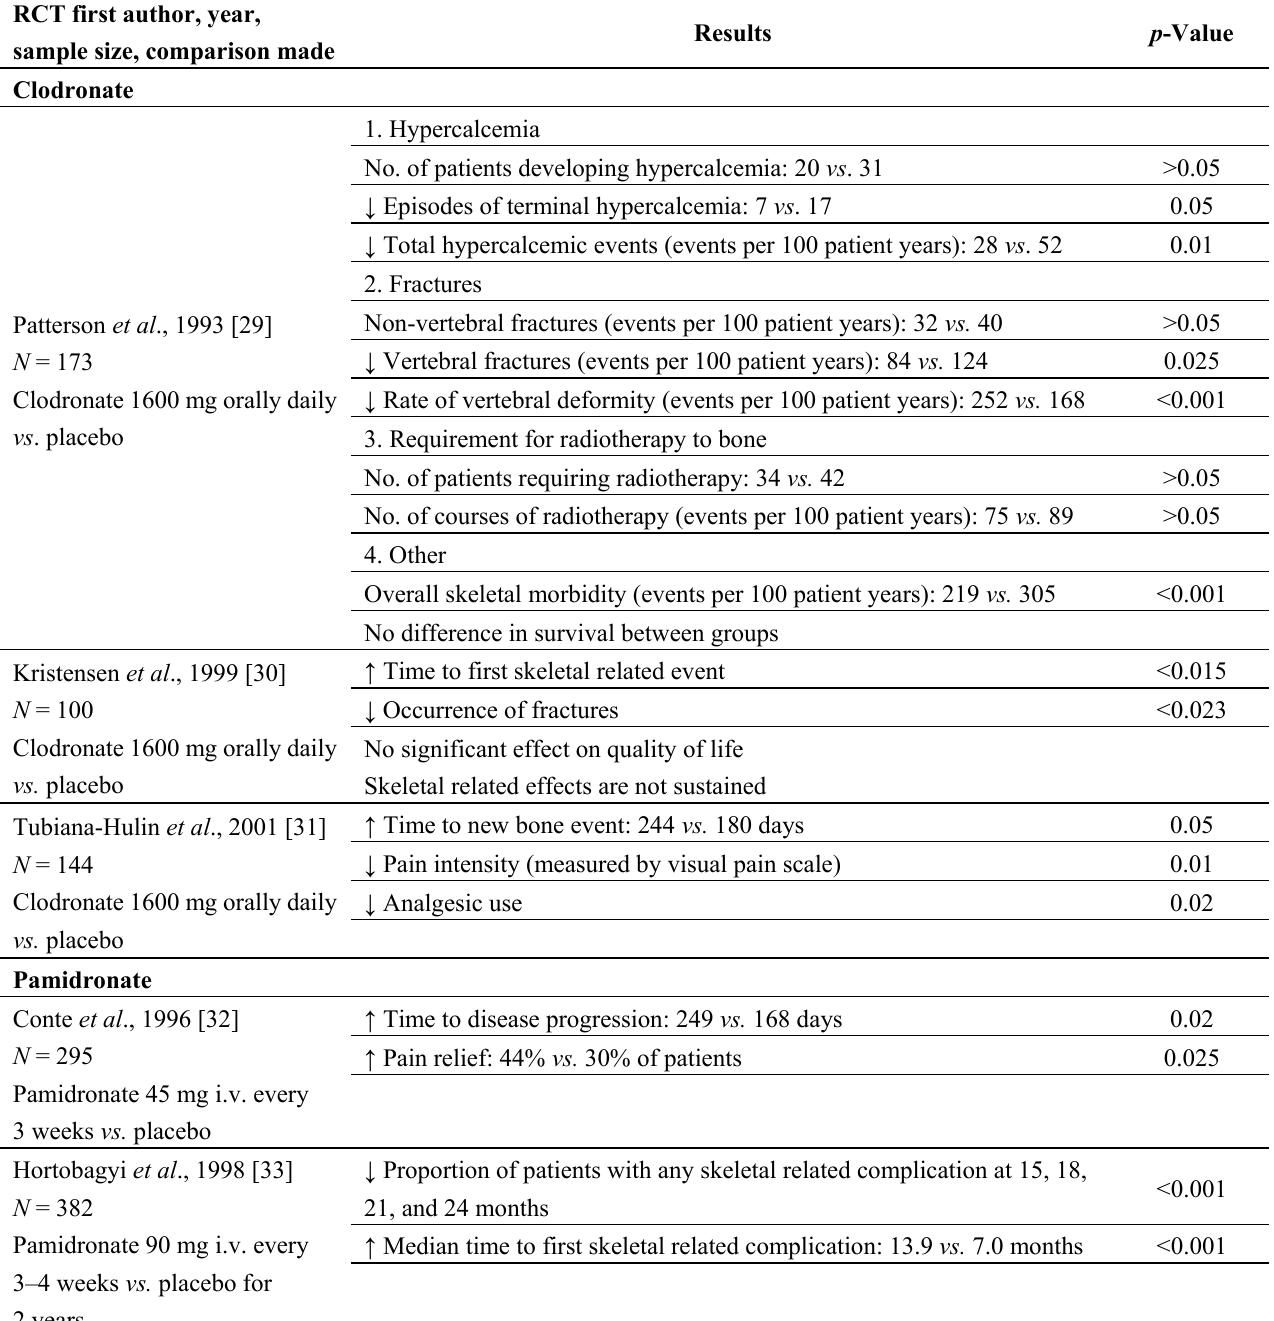
Table 1. Placebo controlled trials of bisphosphonates available for clinical